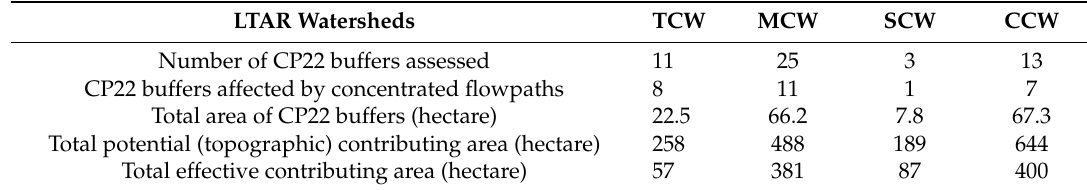
Table 1. Summary of riparian buffer analysis in the Tuckahoe Creek (TCW), Spring Creek (SCW), Conewago Creek (CCW), and Mahantango Creek (MCW) watersheds. LTAR Watersheds TCW MCW SCW CCW Number of CP22 buffers